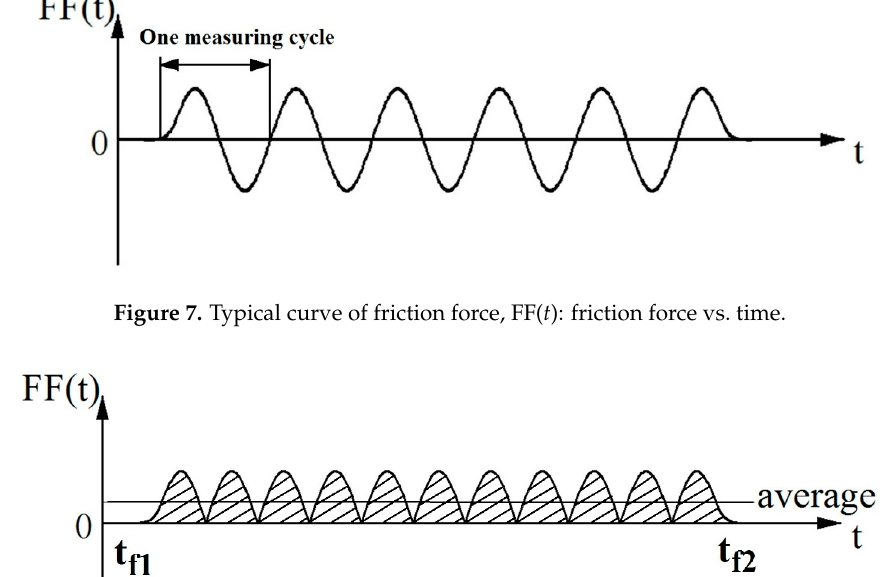
Figure 7. Typical curve of friction force, FF( t ): friction force vs. time.